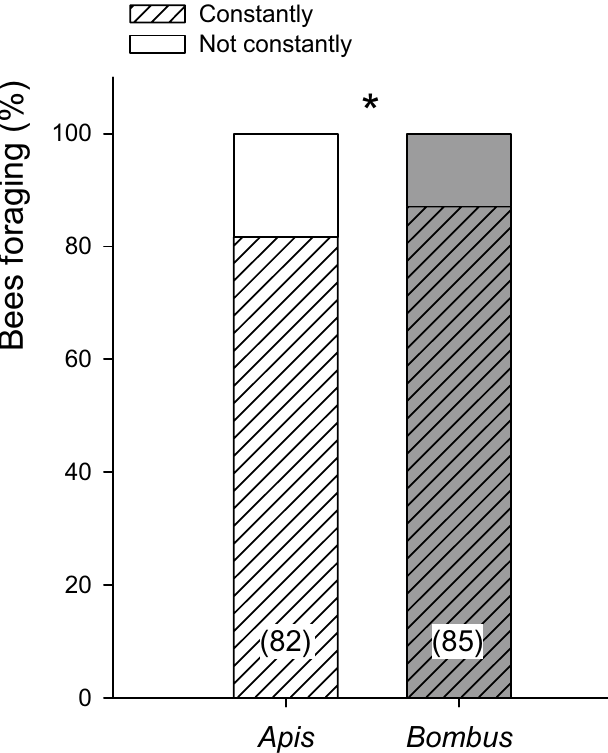
Figure 4. Floral constancy of Apis mellifera and Bombus pauloensis . The percentage of individuals foraging exclusively on the same cultivar is represented with stripes (constantly). Full bars represent the percentage of bees shifting between cultivars (not constantly). Both species exhibited high floral constancy, regardless of the cultivar, but honeybees were more likely to switch between cultivars than bumblebees. Asterisks indicate statistical differences (*, p < 0.05). Sample size indicated in